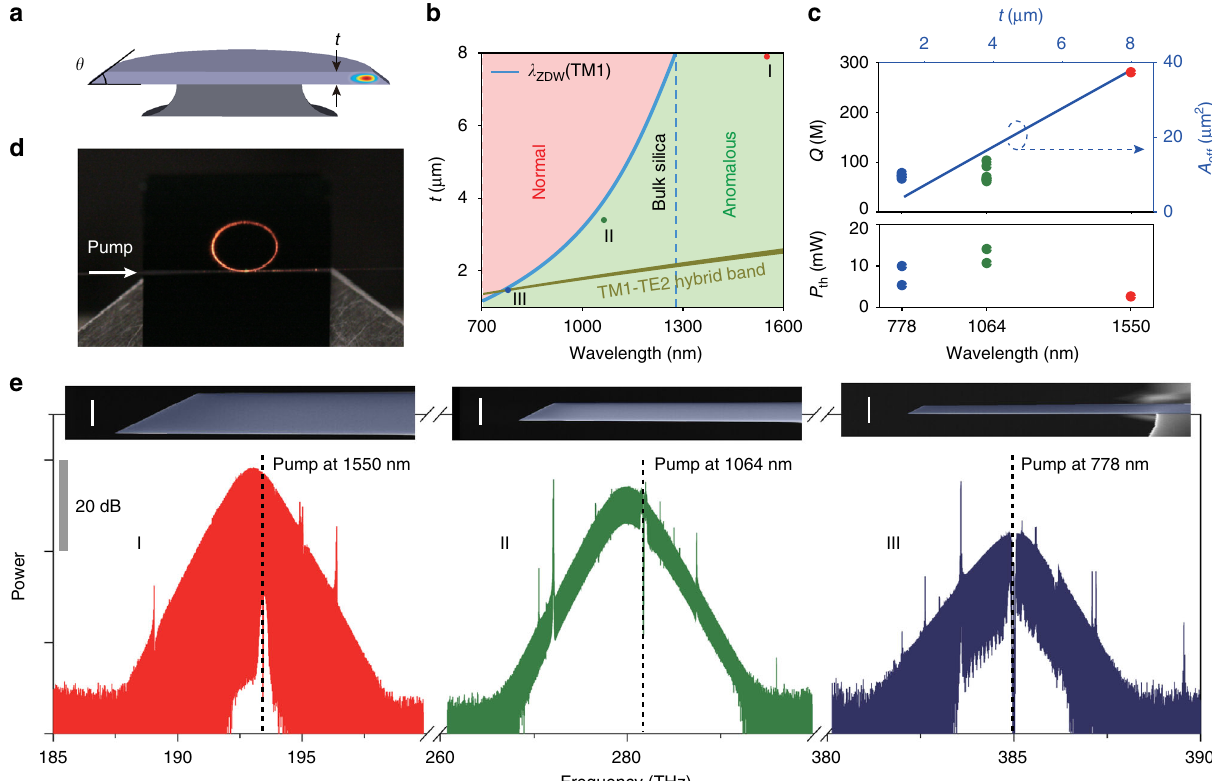
Fig. 1 Soliton frequency comb generation in dispersion-engineered silica resonators. a A rendering of a silica resonator with the calculated TM1 mode pro fi le superimposed. b Regions of normal and anomalous dispersion are shown vs. silica resonator thickness ( t ) and pump wavelength. The zero dispersion wavelength ( λ ZDW ) for the TM1 mode appears as a blue curve. The dark green band shows the 10-dB bandwidth of anomalous dispersion created by TM1-TE2 mode hybridization. The plot is made for a 3.2-mm diameter silica resonator with a 40° wedge angle. Three different device types I, II, and III (corresponding to t = 7.9, 3.4, and 1.5 µ m) are indicated for soliton generation at 1550, 1064, and 778 nm. c Measured Q factors and parametric oscillation threshold powers vs. thickness and pump wavelength for the three device types. Powers are measured in the tapered fi ber coupler under critical coupling. Effective mode area ( A eff ) of the TM1 mode family is also plotted as a function of wavelength and thickness. d A photograph of a silica resonator (Type III device pumped at 778 nm) while generating a soliton stream. The pump light is coupled via a tapered fi ber from the left side of the resonator. The red light along the circumference of the resonator and at the right side of the taper is believed to result from short wavelength components of the soliton comb. e Soliton frequency comb spectra measured from the devices. The red, green, and blue soliton spectra correspond to device types I, II, and III designed for pump wavelengths 1550, 1064, and 778 nm, respectively. Pump frequency location is indicated by a dashed vertical line. The soliton pulse repetition rate of all devices is about 20 GHz. Differences in SNR of the spectra originate from the resolution of the optical spectrum analyzer (OSA). In particular, the 778 nm comb spectrum was measured using the second-order diffracted spectrum of the OSA, while other comb spectra were measured as fi rst-order diffracted spectra. Insets: cross-sectional SEM images of the fabricated resonators. White scale bar is 5 µ